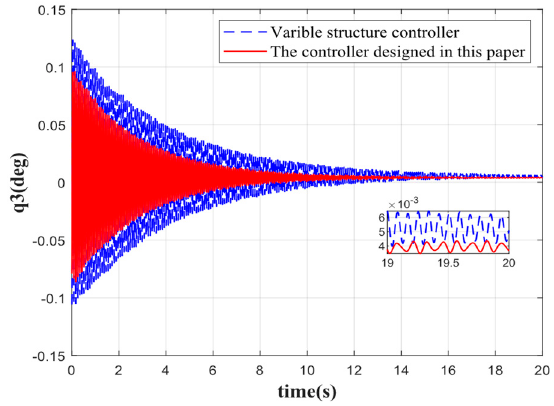
Figure 14. Second ‐ order elastic vibration mode with external interference.